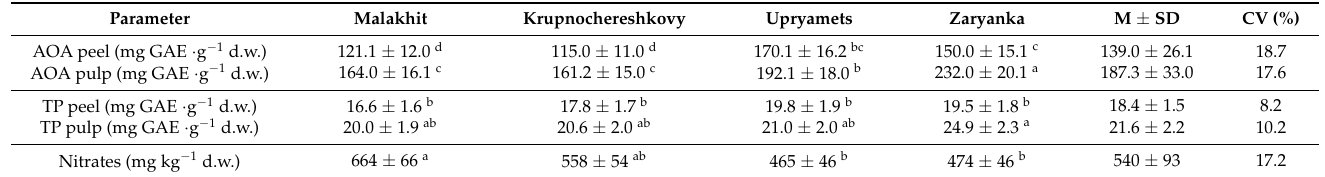
Table 5. Antioxidant status and nitrate content in rhubarb